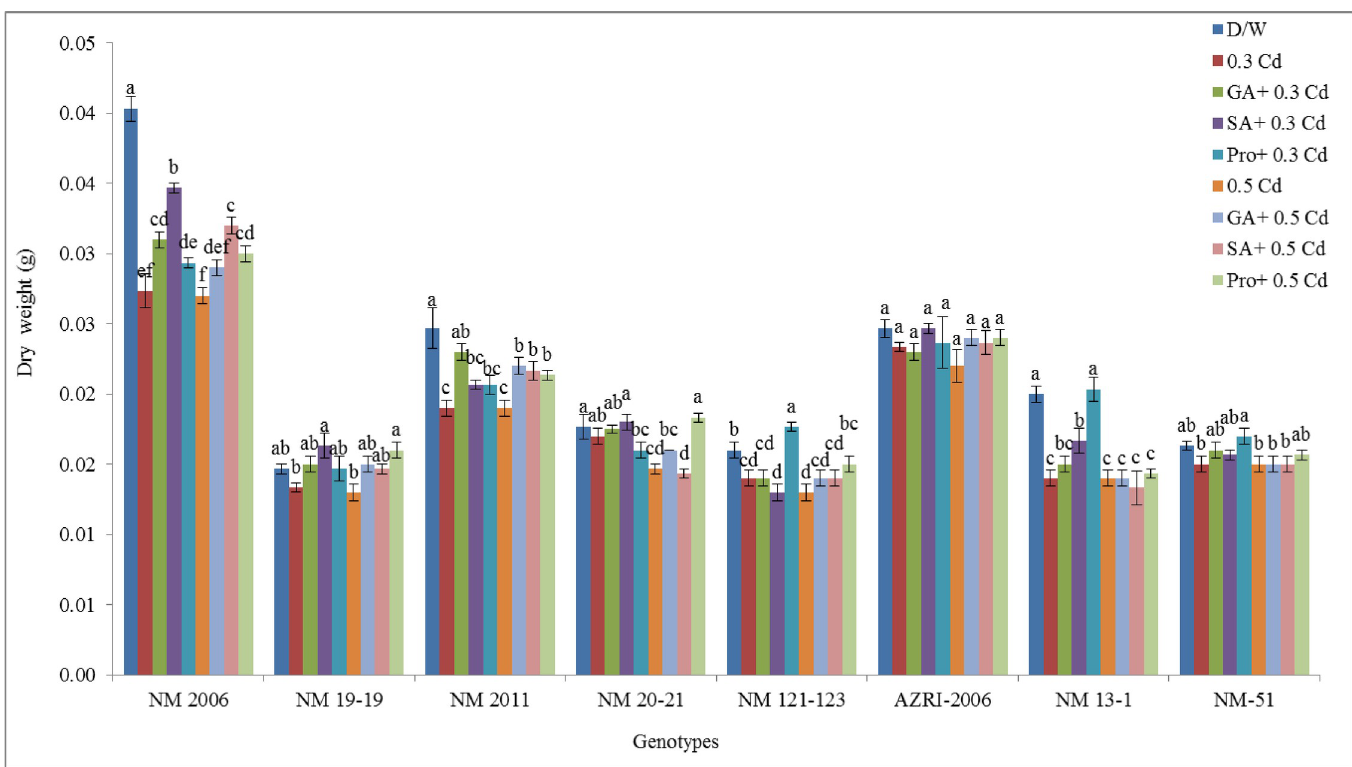
Fig 7. Mean dry weight of mung bean grown under Cd and pretreatments of GA 3 , SA and proline prior to Cd.